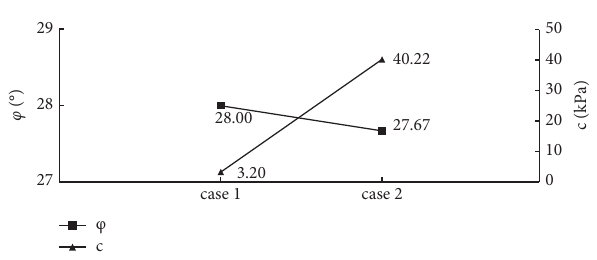
Figure 11: Variation curve of shear strength